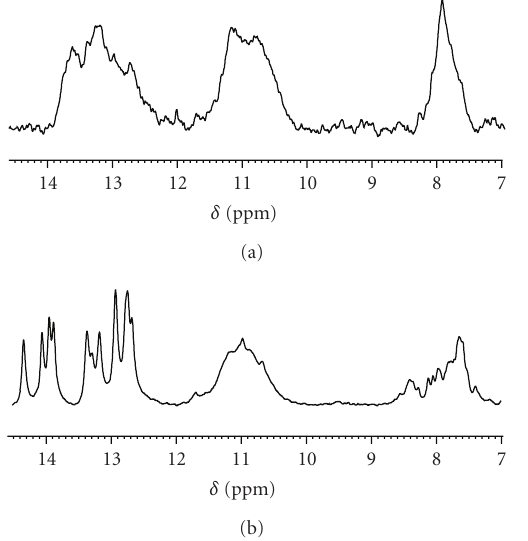
Figure 4: Circular dichroism spectra of parallel clamp 4 , parallel clamp 5, and parallel clamp 6 (Conditions 50 mM MgCl 2 , 10 mM sodium cacodylate pH